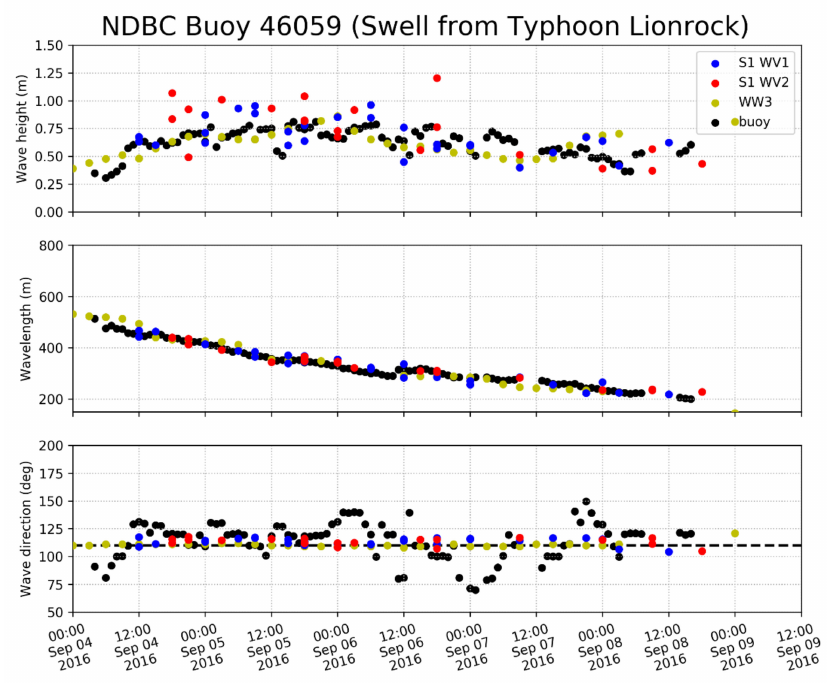
Figure 18. As in Figure 16, but for the case of a swell event originated from Typhoon Lionrock on 29 August at the buoy #46059 (38.05 ◦ N/129.90 ◦